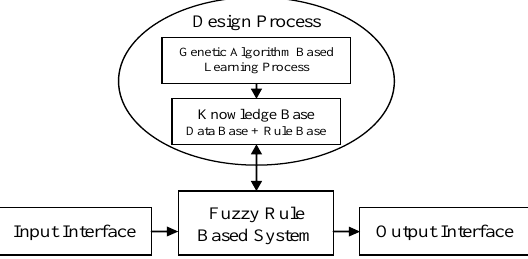
Figure 4. Genetic fuzzy systems structure (Herrera, 2008)